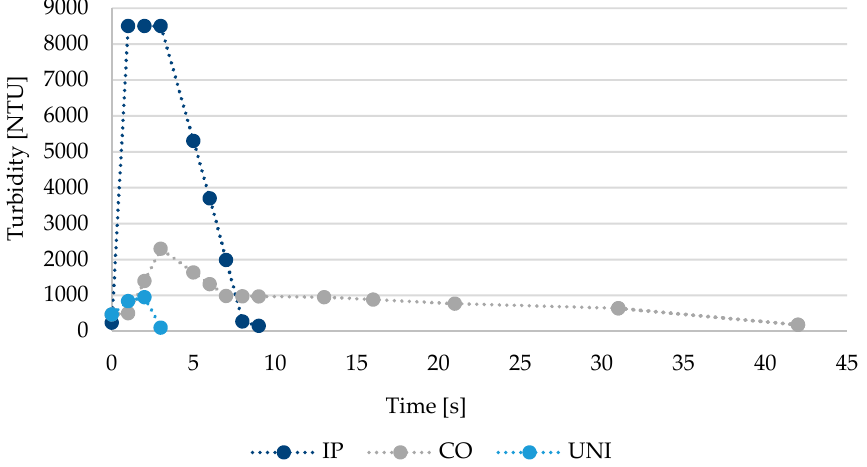
Figure 4. The distribution of the measured turbidity shows the principle by which particles are carried out of the pipeline (IP—Ice Pigging ® , CO—Comprex ® , UNI—Unidirectional flushing).